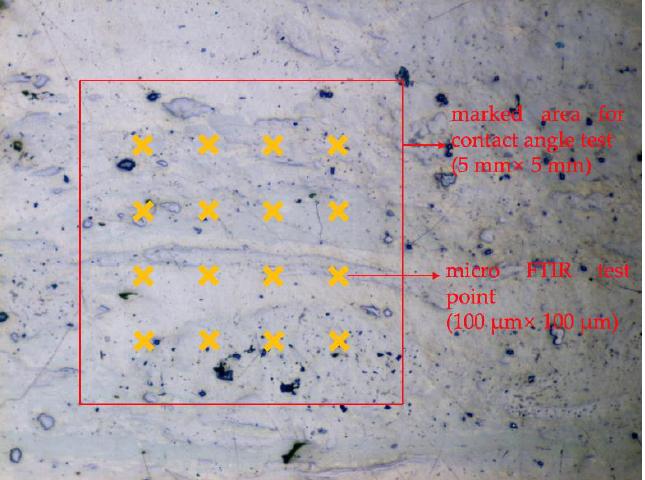
Figure 1. Schematic of micro-FTIR test points on the polished coal surface.